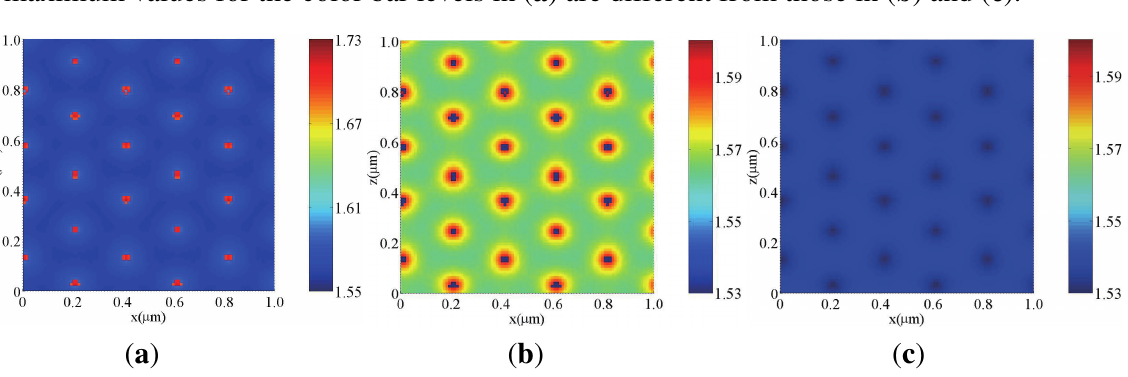
Figure 6. Calculated refractive index distributions by p-polarized three-beam interference holographic polymerization when no E is applied for ( a ) s (TM) and ( b ) p (TE) wave ex readout, and ( c ) when E is applied for any polarized wave. Note that the minimum and ex maximum values for the color bar levels in ( a ) are different from those in ( b ) and ( c